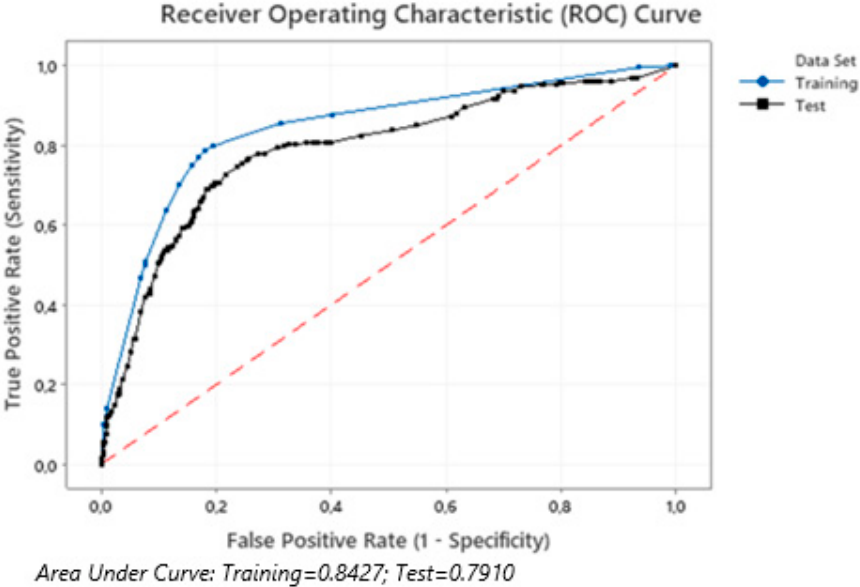
Figure 3. The area under the ROC curves of the all-cause mortality prediction model for patients in the training and test cohorts.